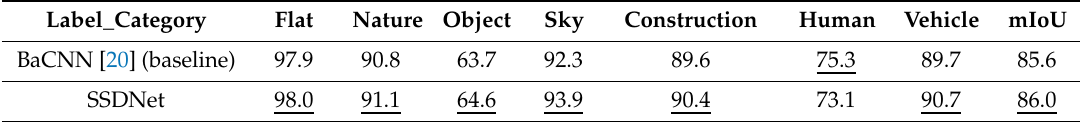
Table 5. Detailed IoU (in %) on CityScapes with an image resolution of 512 × 1024 px.